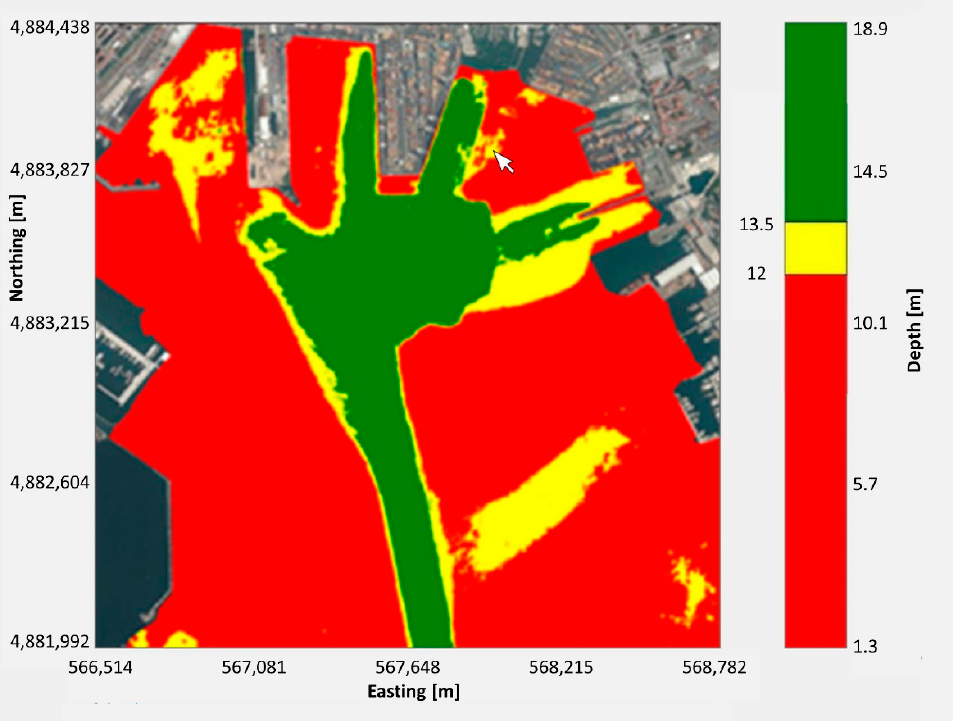
Figure 8. Virtual traffic lights in the port of La Spezia on 30 June 2010 at 12:00 UTC (threshold levels 12 and 13.5 m).